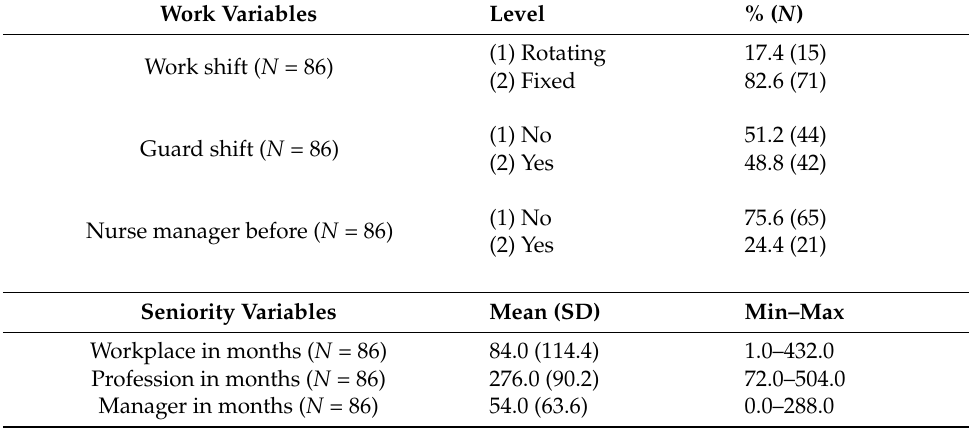
Table 2. Descriptive study of relevant work and seniority variables.